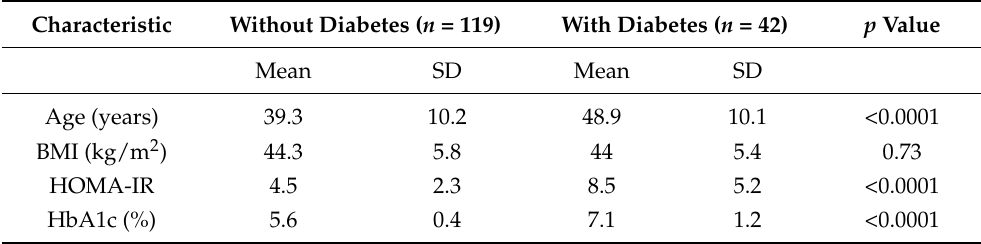
Table 3. Characteristics of patients with or without preoperative type 2